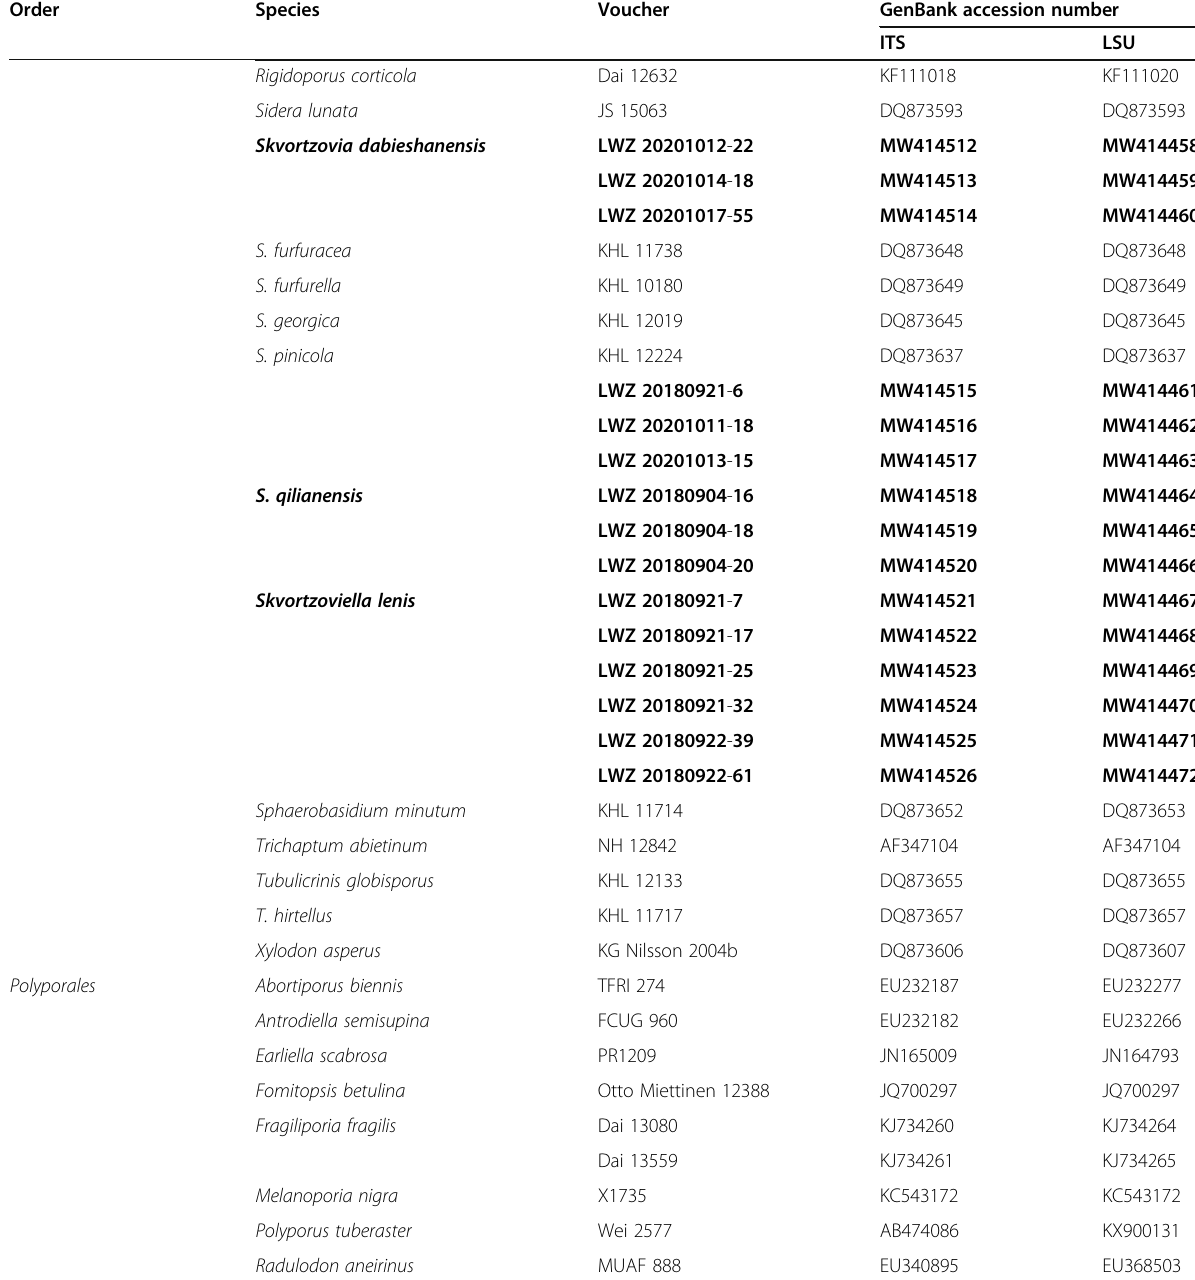
Table 1 Information of species used in phylogenetic analyses (Continued)